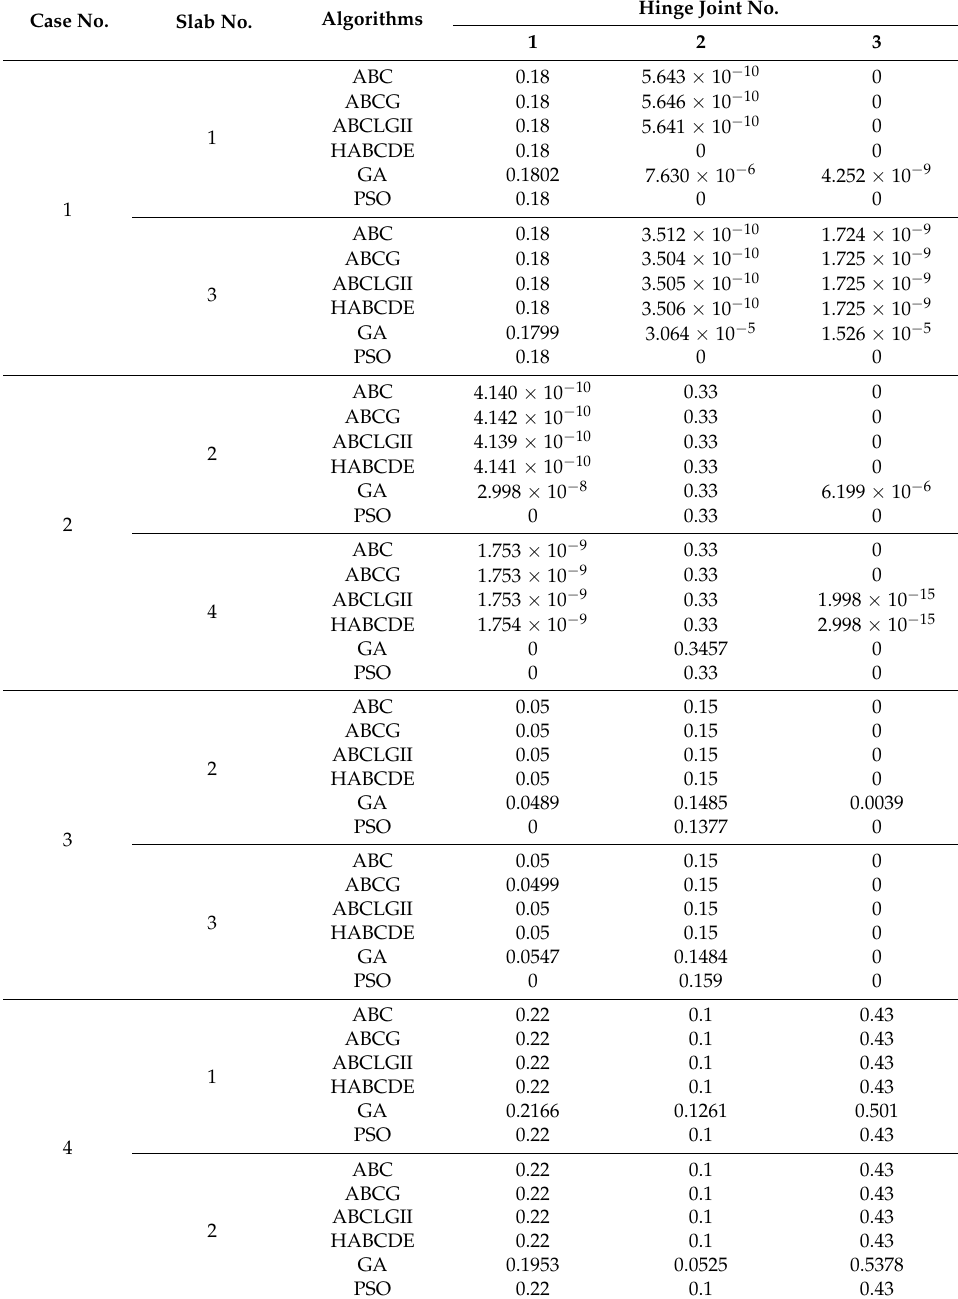
Table 6. Damage identification results for cases 1 to 4.